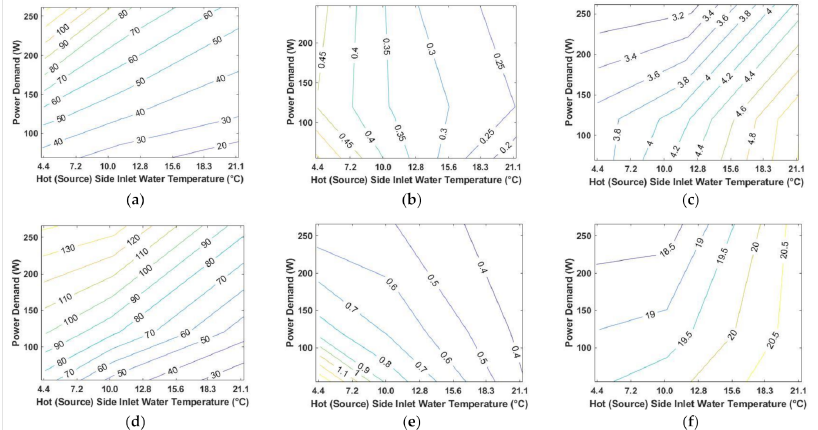
Figure 6. Cooling capacities and COPs: ( a ) Cooling Capacity, ( b ) Cooling COPs, and ( c ) Cold Side Surface T with the cold (load) side inlet water temperature of 4.4 ◦ C (4.4~4.9 ◦ C); ( d ) Cooling Capacity, ( e ) Cooling COPs, and ( f ) Cold Side Surface T with the cold (load) side inlet water temperature of 21.1 ◦ C (20.6~21.6 ◦